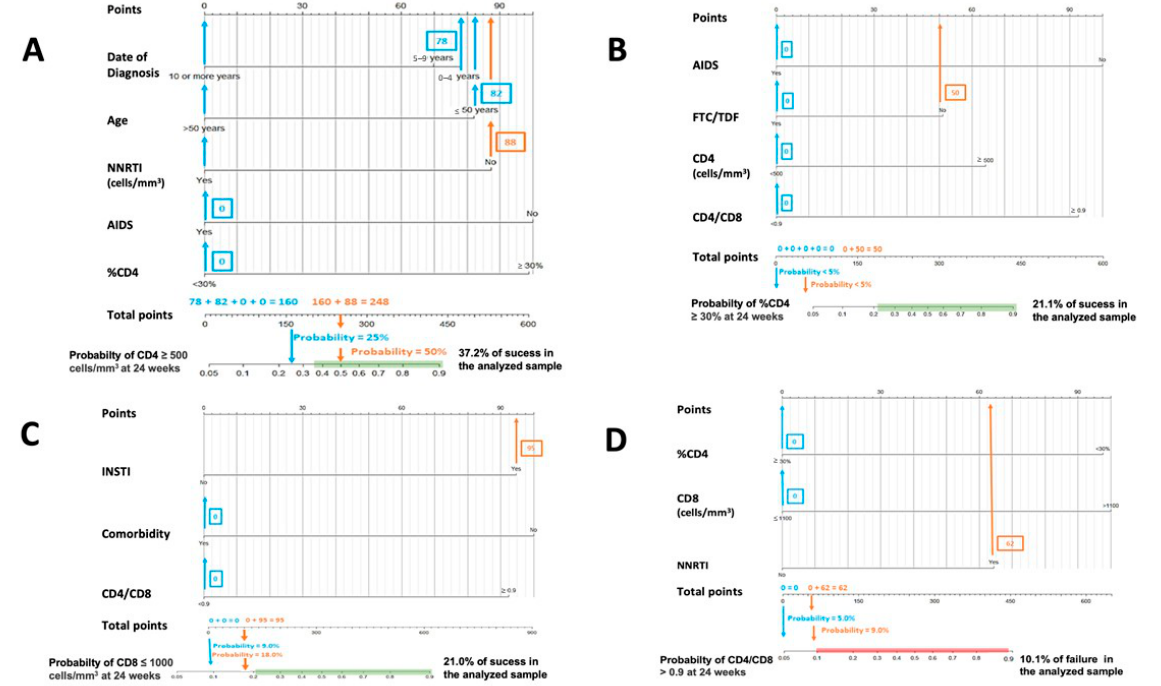
Figure 1. Nomograms to predict the probability of success at 24 weeks. ( A ) Nomogram to predict the probability of achieving CD4 ≥ 500 cells/mm 3 at 24 weeks in PLWHIV treated with DTG plus 3TC and with basal CD4 values < 500 cells/mm 3 : ( B ) nomogram to predict the probability of achieving CD4 ≥ 30% at 24 weeks in PLWHIV treated with DTG plus 3TC and with basal %CD4 < 30%; ( C ) nomogram to predict the probability of achieving CD8 ≤ 1100 cells/mm 3 at 24 weeks in PLWHIV t treated with DTG plus 3TC and with basal CD8 > 1100 cells/mm 3 ; ( D ) nomogram to predict the probability of achieving CD4/CD8 ≥ 0.9 at 24 weeks in PLWHIV treated with DTG plus 3TC and with basal CD4/CD8 <